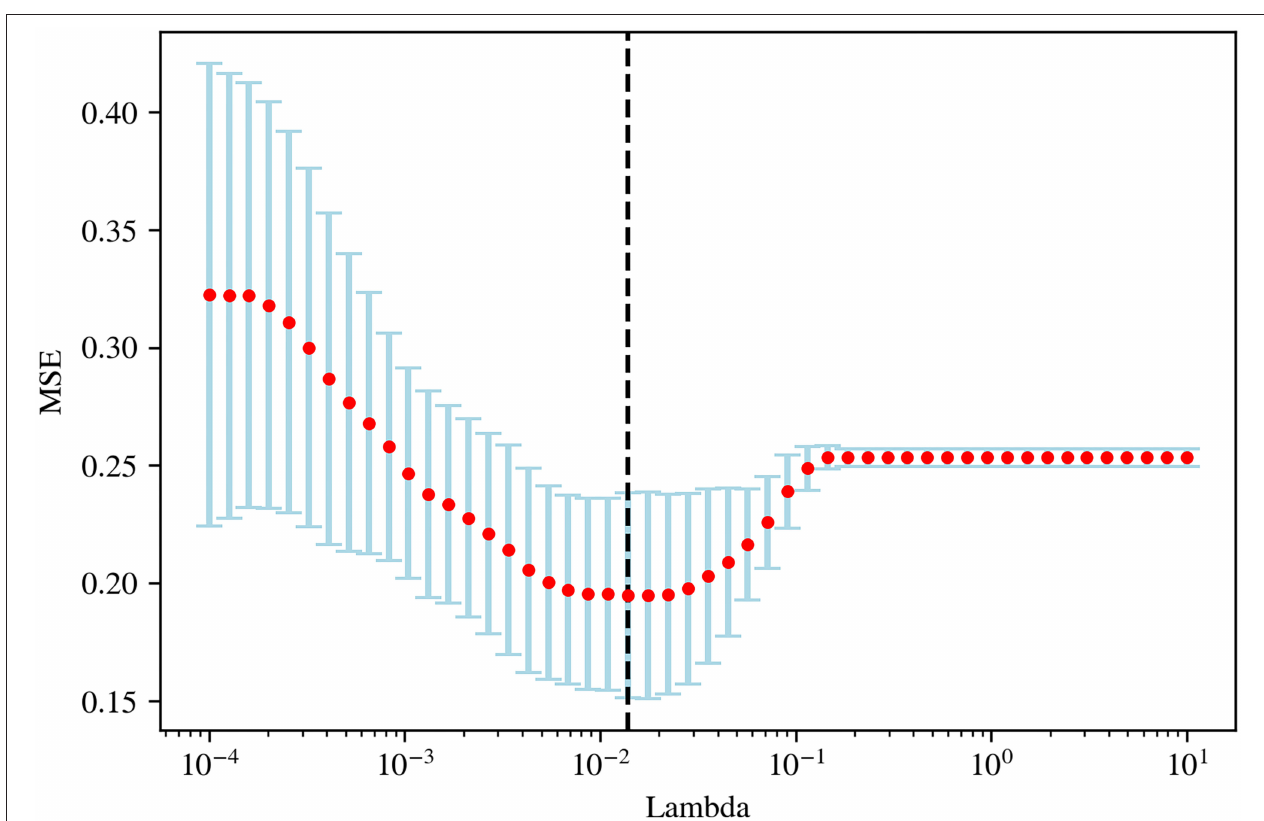
FIGURE 2 | The optimal lambda value (0.0136) in least absolute shrinkage and selection operator (LASSO) regression.